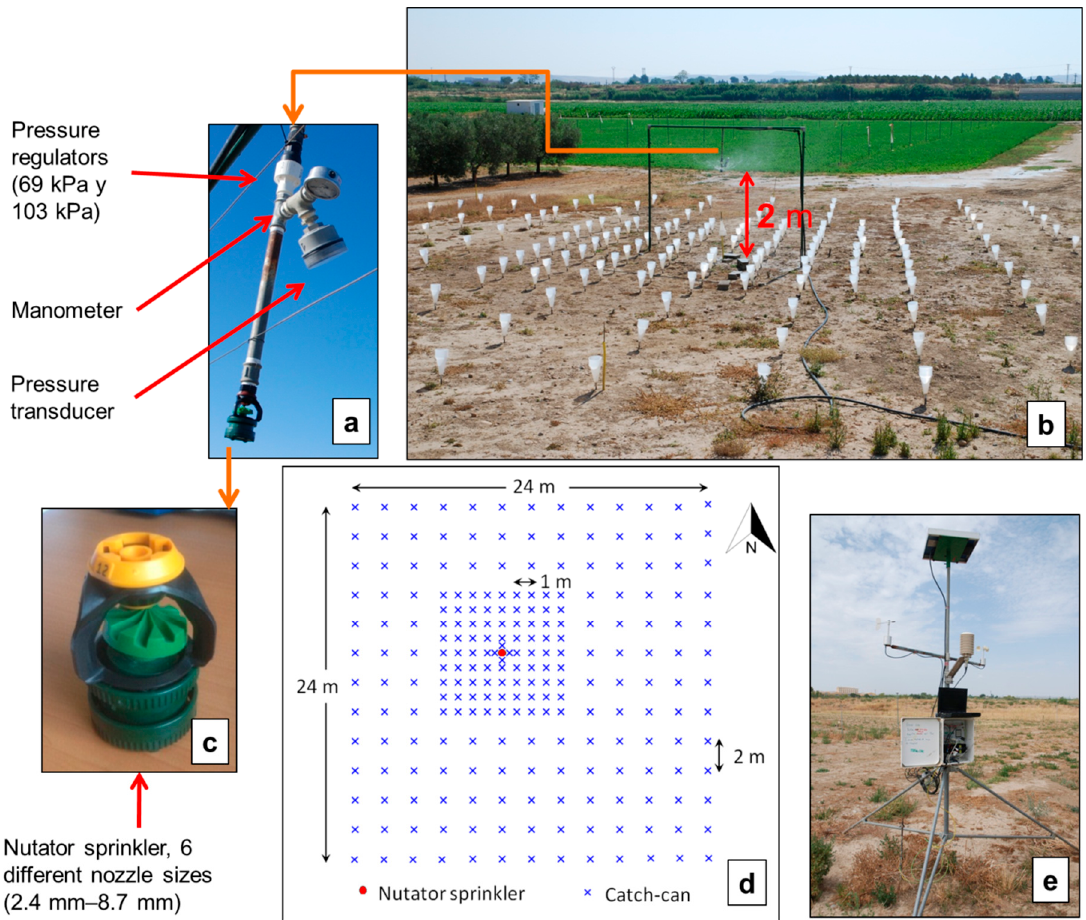
Figure 1. Experimental set-up for the characterization of the water application patterns of the Nutator sprinkler: ( a ) isolated Nutator sprinkler and its components (pressure regulators, manometer and pressure transducer); ( b ) field experimental layout; ( c ) Nutator sprinkler; ( d ) experimental catch-can set-up; ( e ) meteorological weather station.